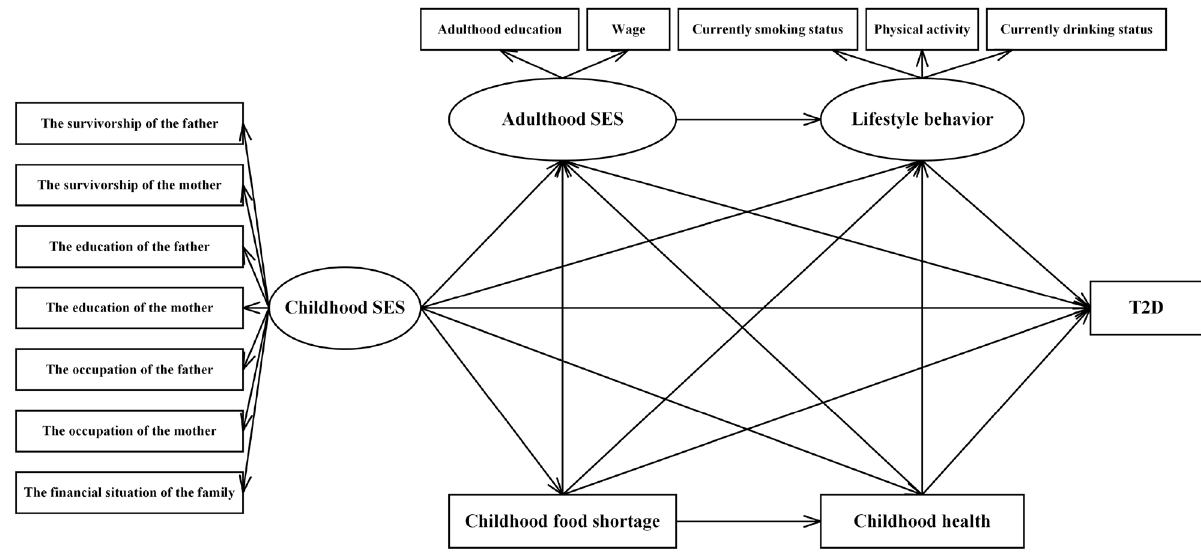
Figure 1. Hypothesized pathways from childhood SES to T2D in mid-late adulthood in the conceptual model. SES socioeconomic status, T2D type 2